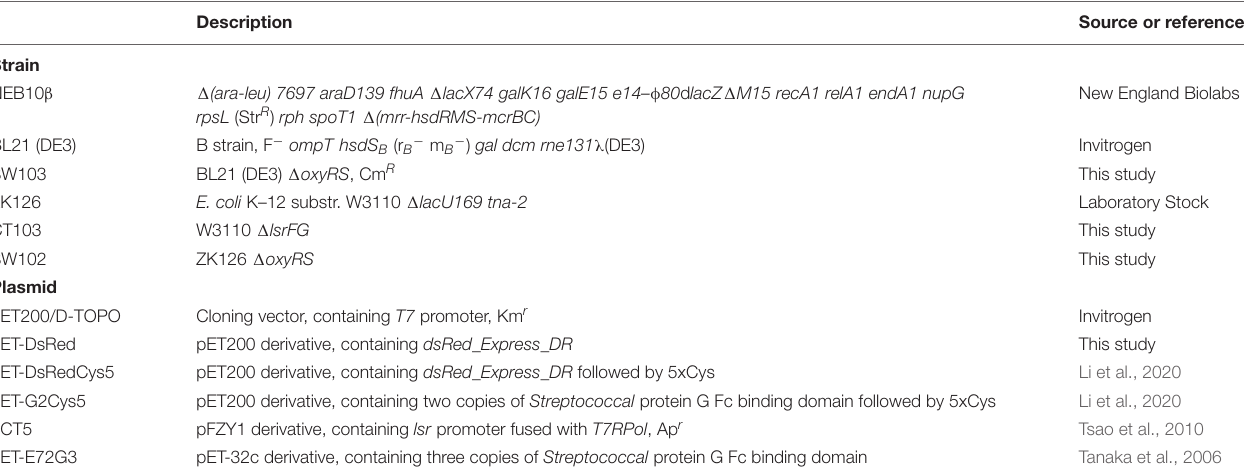
TABLE 1 | Bacteria strains and plasmids used in this